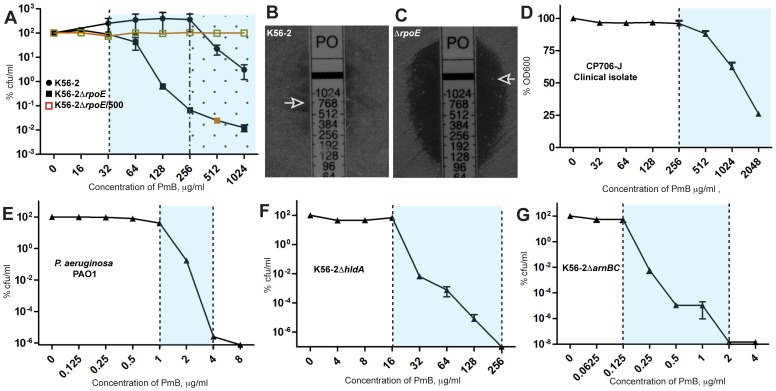
Heterogeneous response of B. cenocepacia to PmB.Population analysis profiling (PAP) of B. cenocepacia strains K56-2, K56-2ΔrpoE, K56-2ΔrpoE/500, CF706-J, K56-2ΔhldA, and K56-2ΔarnBC, and P. aeruginosa PAO1 by agar dilution at 24 h except for CF706-J by broth dilution at 18 h. n = 6. Panels (B) and (C), E-test showing discrete colonies at otherwise clear zones of inhibition, indicating heterogeneous response to PmB.